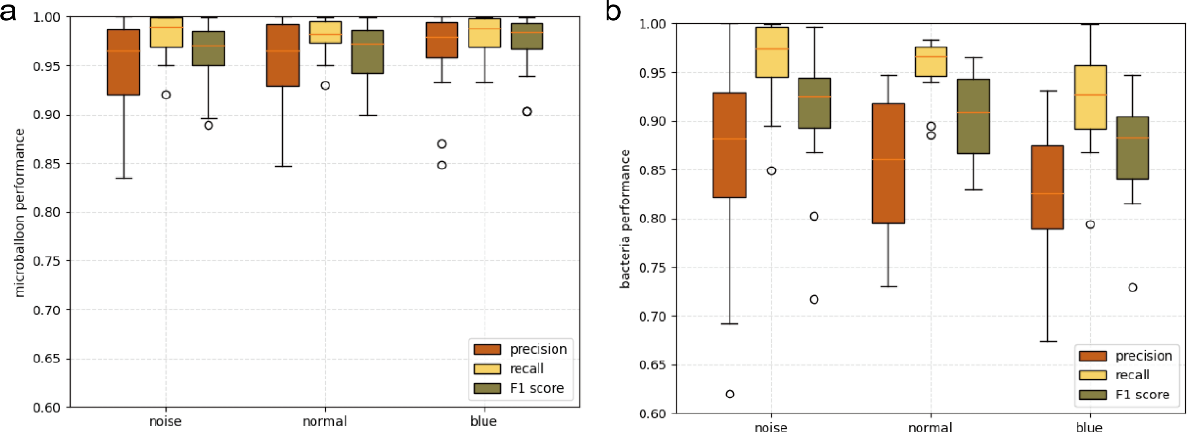
Figure 5. Performance description with box diagram as precision (red), recall (yellow), and F1 score (green) obtained with the blue background stained with trypan blue (N = 20), loud noise background (N = 20), and normal background (N = 20) datasets. ( a ) microballoon recognition performance; ( b ) bacteria recognition performance.